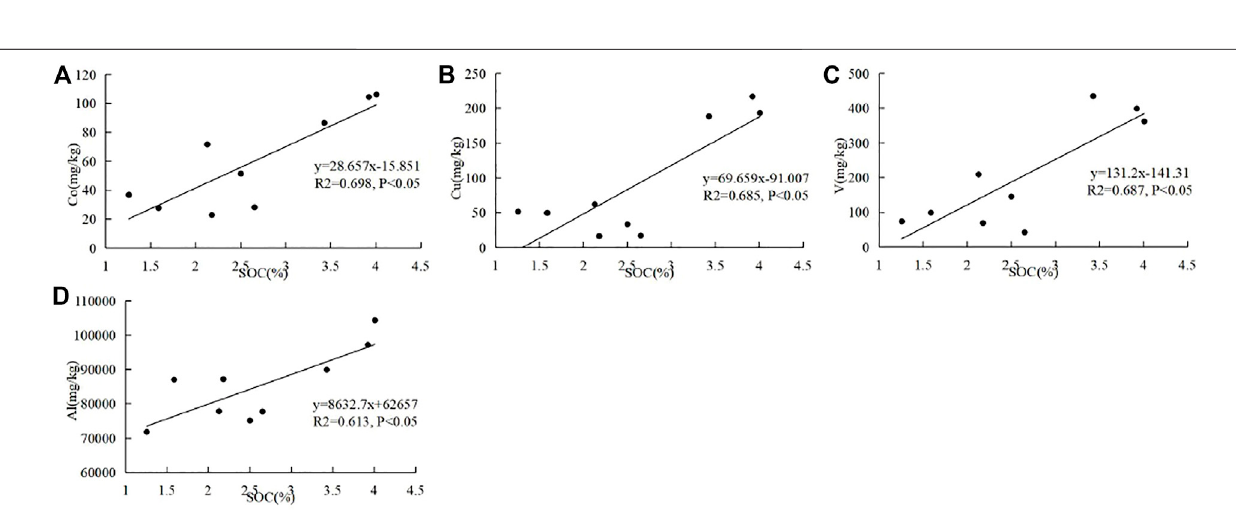
FIGURE 5 | Correlations of SOC with Co (A) , Cu (B) , V (C) , and Al (D) in the surface